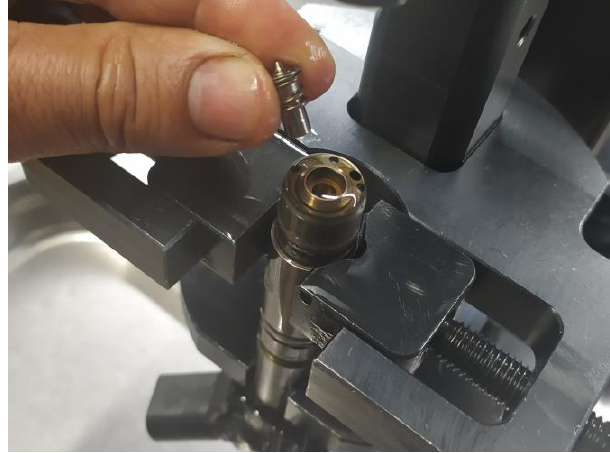
Fig. 10. Assembly of the hydraulic booster